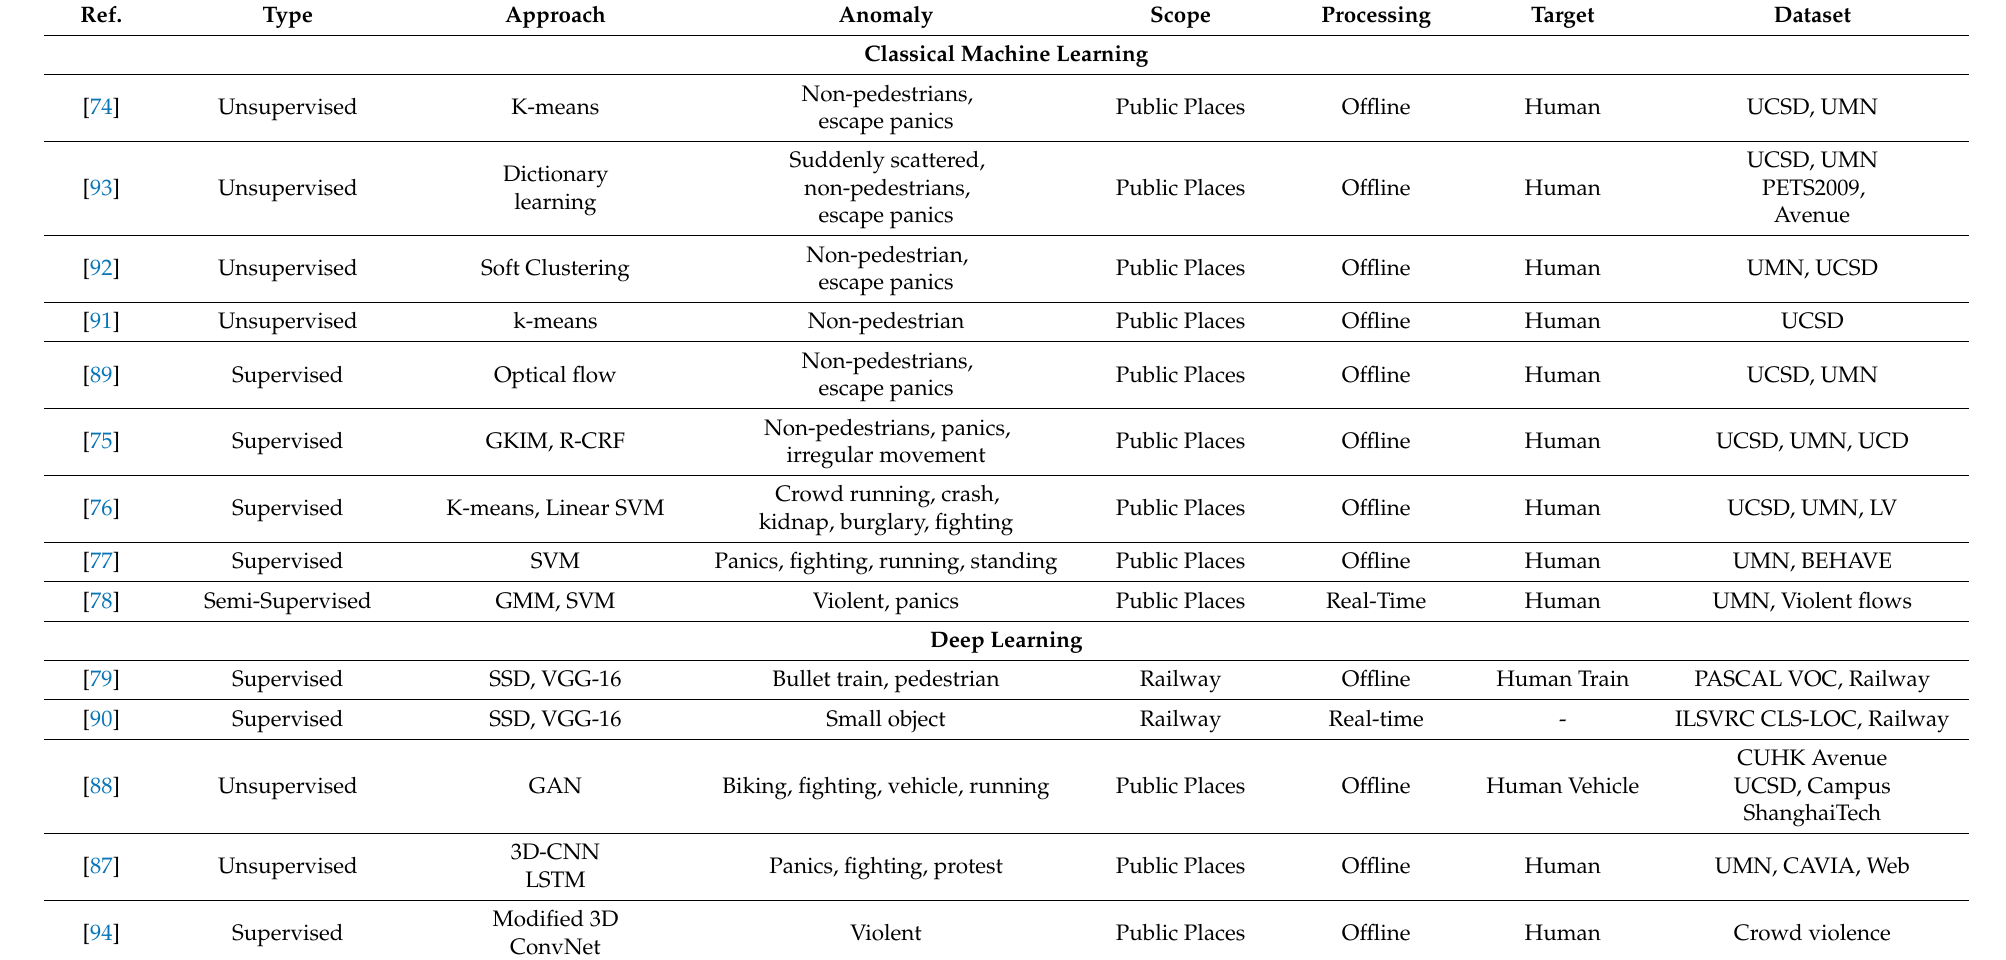
Table 2. Categorization of the state-of-the-art anomaly detection methods in crowd scenes.